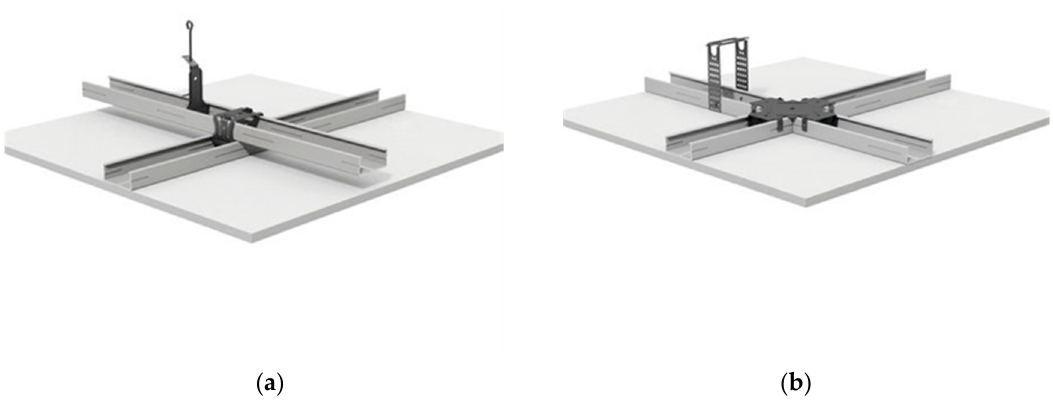
Figure 4. Drywall non-structural architectural components: suspended ceilings. ( a ) Suspended ceiling without a flush profile frame; ( b ) suspended ceiling with a flush profile frame. Buildings 2019 , 9 , x FOR PEER REVIEW